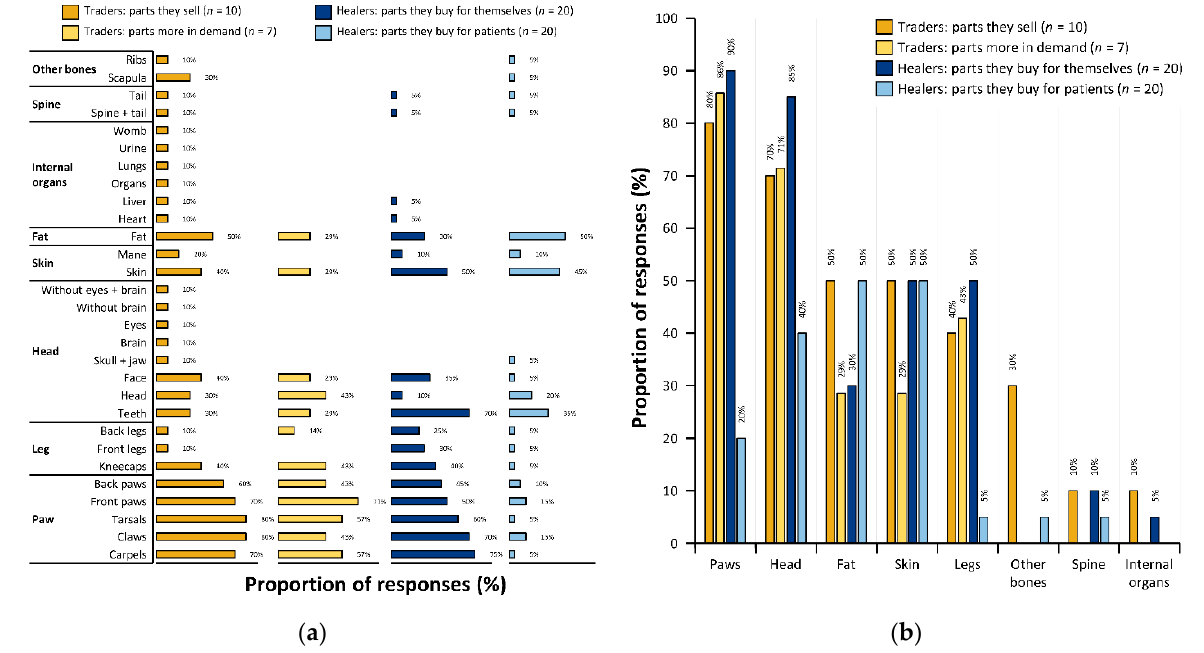
Figure 4. Trader and healer requests, preferences, and demand for lion derivatives. ( a ) Lion derivatives itemized on the questionnaire graphic and (i) the % traders that sell these derivatives ( n = 10 traders); (ii) the % traders indicating that these derivatives are in more demand ( n = 7); (iii) the % healers buying these derivatives for themselves to use in their practices ( n = 20); and (iv) the % healers buying these derivatives for their patients/customers ( n = 20). ( b ) Lion derivatives summarized as broad part types, and (i) the % traders that sell derivatives obtained from these part types ( n = 10 traders); (ii) the % traders indicating that derivatives from these types are in more demand ( n = 7); (iii) the % healers buying derivatives from these types for themselves to use in their practices ( n = 20); and (iv) the % healers buying derivatives from these types for their patients/customers ( n = 20). Paw part derivatives = claws, carpels, tarsals, and whole front and back paws. Head part derivatives = teeth, skull, jaw, face/muzzle, whole head, brains, and eyes. Fat = body fat. Skin derivatives = mane; full or partial skin and skin pieces. Leg part derivatives = kneecap, front and back legs (bones of whole). Other bones = ribs, scapula. Spine = spine, tail. Internal organ derivatives = heart, liver, lungs, womb, and urine. Table 1. The degree of similarity of lion parts cited between and within respondent groups, expressed as the number of shared parts and the Sørenson’s similarity index (SSI) percentage of shared